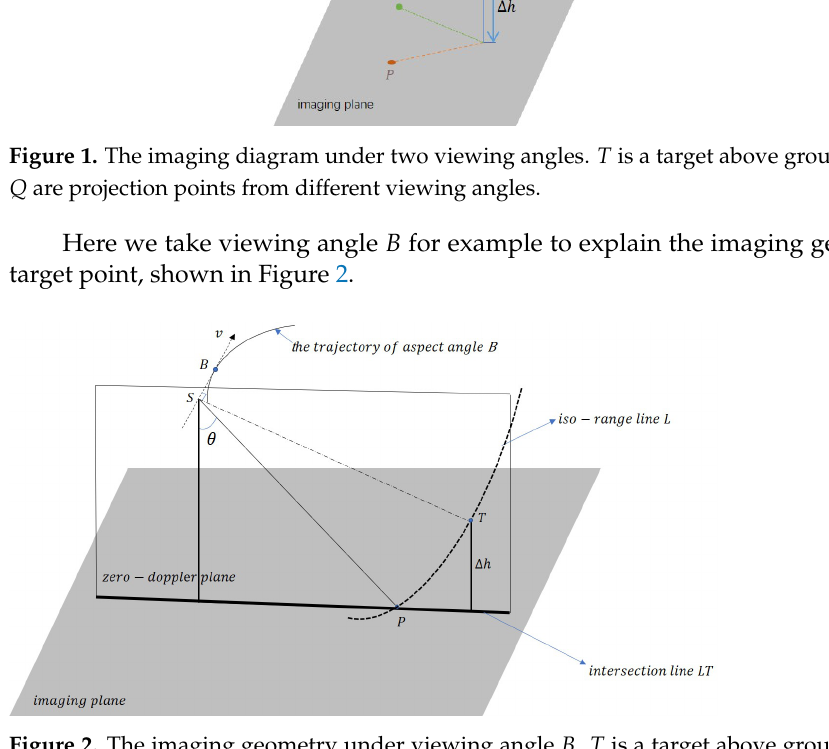
Figure 2. The imaging geometry under viewing angle B . T is a target above ground plane. P is a projection